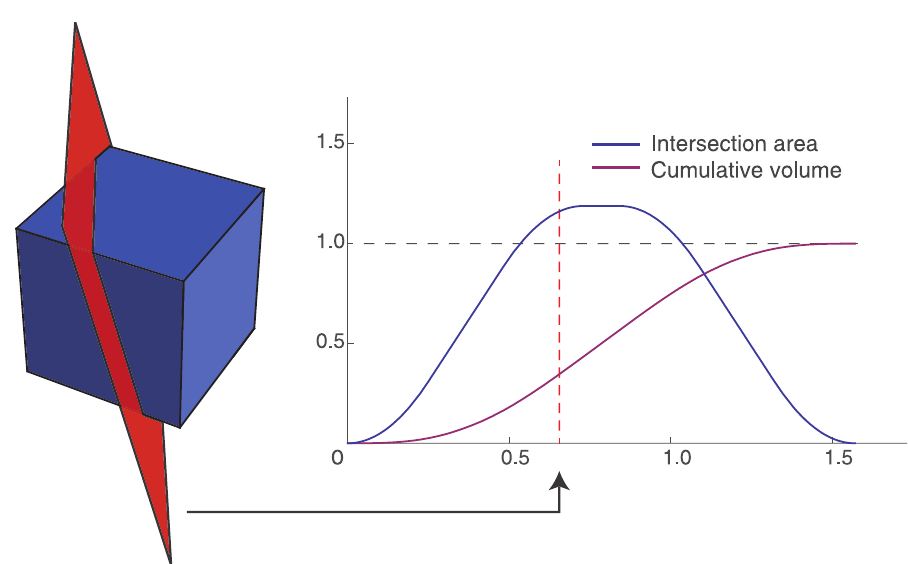
Fig 1. The plane of arbitrary normal ~ n (here ~ n ¼ ð n parts (red dashed line). As the plane moves in the direction of its the normal, the area of intersection varies, as indicated by the blue curve. The volume within the voxel on the left side of the plane is indicated by the cumulative volume and represented by the purple